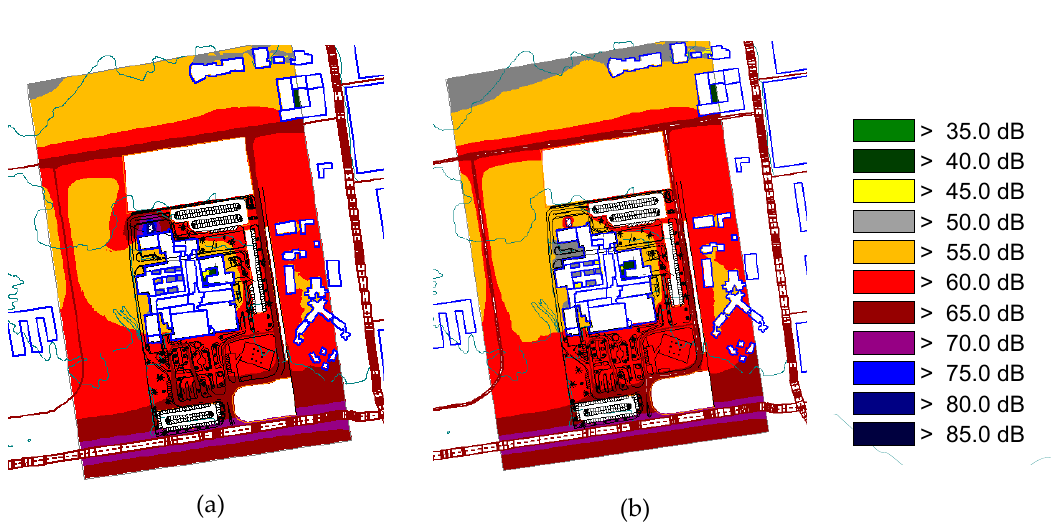
Figure 9. Comparative of the noise model before and after corrective actions: ( a ) Without any corrective action. ( b ) After applying all the corrective actions.